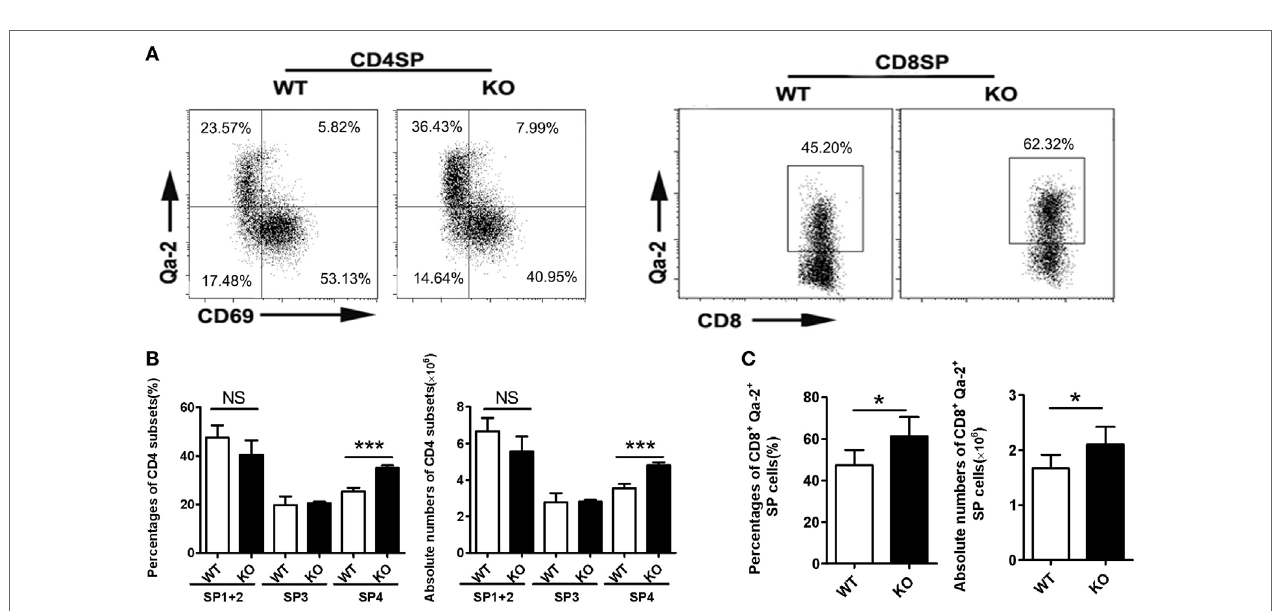
FigUre 3 | Accumulation of Qa-2 + mature single-positive (SP) thymocytes in Ccr2 − / − mice. (a) CD69 and Qa-2 staining for CD4 ( Left ) and Qa-2 staining for CD8 SP thymocytes ( Right ). (B) Percentages and absolute numbers of various subsets of CD4 SP cells. (c) Percentages and absolute numbers of CD8 + Qa-2 + cells in the thymus of 6-week-old mice. Data are presented as mean ± SD with at least 10 mice for each group. * p < 0.05, *** p < 0.001.